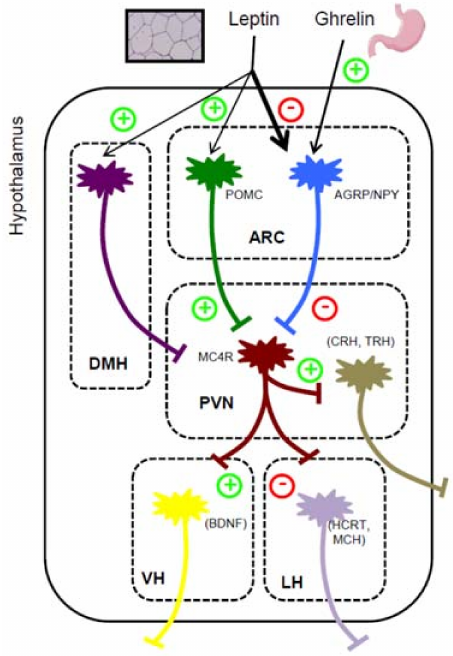
Figure 1. PC1/3-mediated processing of neuropeptides implicated in central regulation of